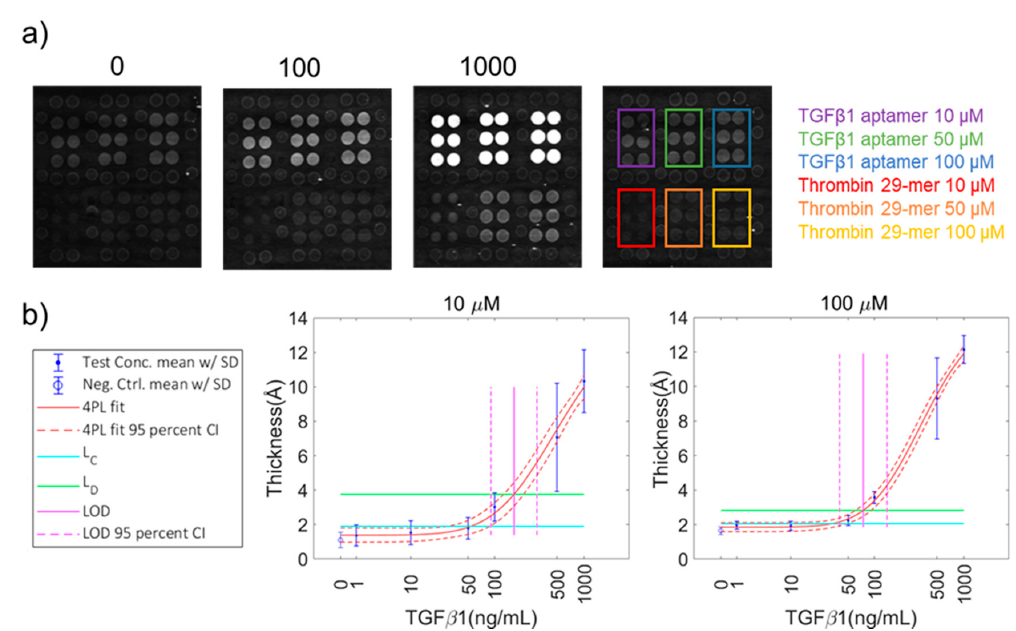
Figure 4. AIR detection of TGF β 1 using an aptamer probe. Representative array images of chips incubated in TGF β 1 protein at concentrations including 0 (control), 100 ng/mL, and 1000 ng/mL. All images were taken with a 500-ms exposure time. The baseline thickness of the TGF β probes is greater than thrombin 29-mer probes, resulting in brighter spots in the 0 ng/mL image. As discussed in the introduction and methods, AIR is a differential measurement, and differences in baseline probe thickness are accounted for by the control chip. A map indicates the location of probes on each chip; probes are in six packs surrounded by normalizing probes ( a ). Plots of normalized thickness vs. target protein concentration were fitted with 4 parameter logistic curves and used to calculate limit of detection (LOD) for each protein concentration. Only the highest (100 µM) and lowest (10 µM) probe concentration plots are shown here. Error bars represent the standard deviation of all probe replicates (n ≥ 8) ( b ).